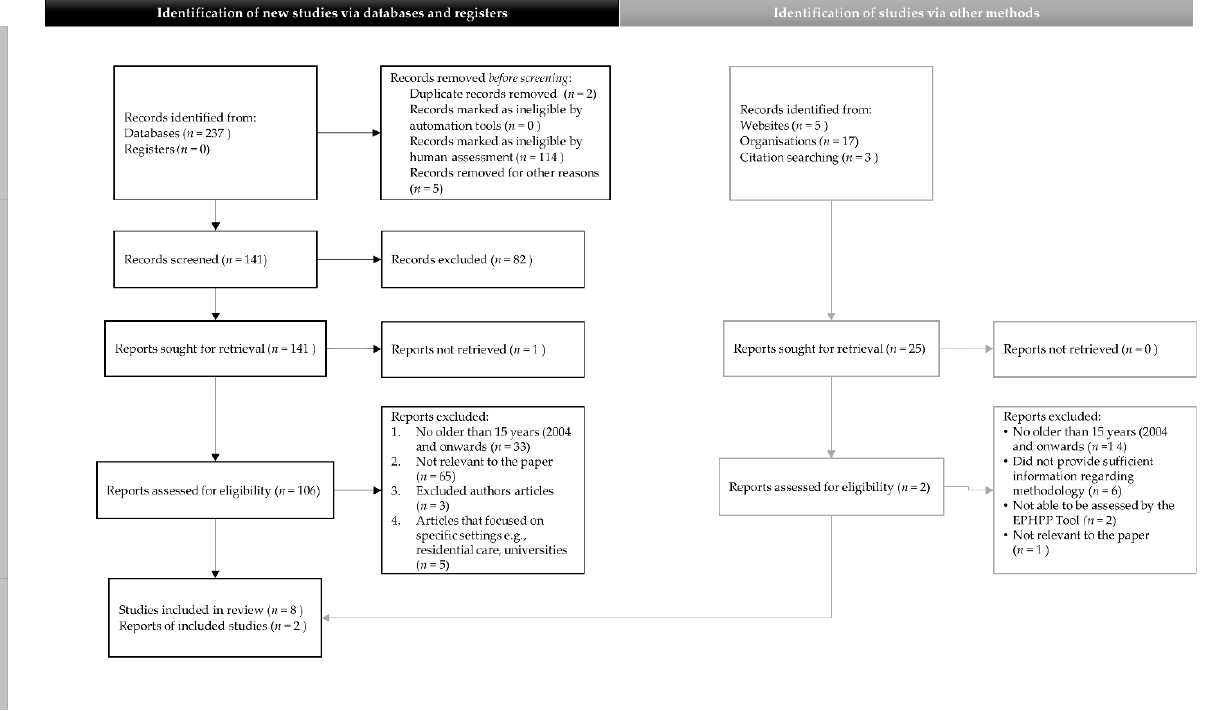
Figure 1. PRISMA flow diagram for reference inclusion.